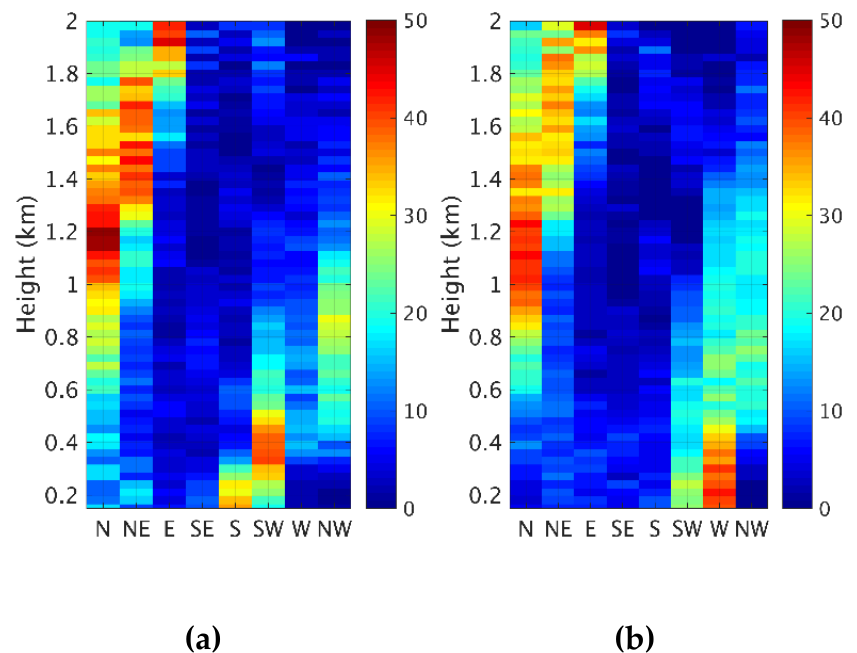
Figure 10. Vertical profiles of horizontal wind direction frequency during HPEs at CUHK ( a ) and KP ( b ). The prevailing horizontal wind directions for heights less than 0.60 km were south and southwest at the CUHK site and west and southwest at the KP site. In addition to lower horizontal wind speed, the prevailing westerly wind during HPEs introduced regional TAP from the Greater Bay Area to Hong Kong. Figure 11 depicts the weather chart of each HPE. The weather charts show that, in each HPE, a typhoon was located in South China sea (east of Hong Kong). The westerly wind was induced by the typhoon-associated counterclockwise wind flow, providing a wind environment for transboundary air pollution within the region [25] and thus, the formation of a HPE. For heights from 0.60 to 1.20 km, northerly and northwesterly wind predominated. For heights from 1.20 to 1.90 km, the prevailing horizontal wind directions was north and northeast. For heights greater than 1.90 km, the easterly winds